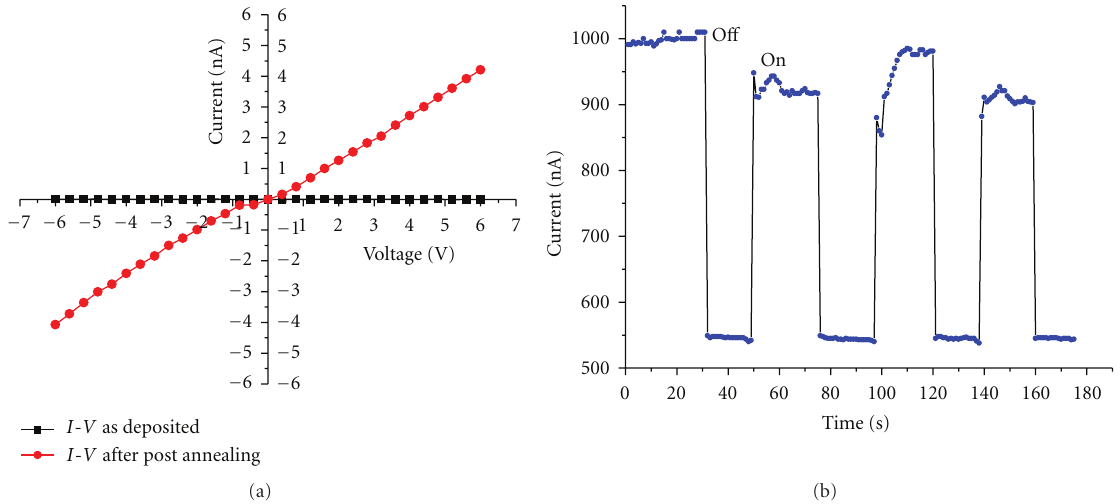
Figure 8: (a) Electrical conductivity of as-deposited and annealed (at 400 ◦ C-1hr in air) 50nm thick ZnO NW. (b) Current-time switching cycles curve at constant voltage of 2V under UV